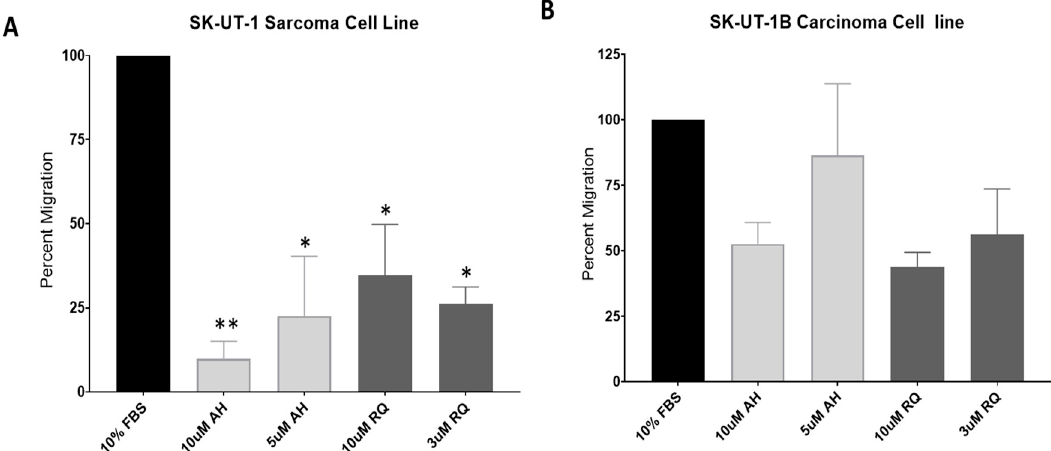
Figure 5. Effect of EP4 antagonists AH23848 and RQ15986 on SK-UT-1 and SK-UT-1B migration. ( A , B ) Addition of EP4 antagonists AH23848 and RQ15986 lead to a decrease in migration in SK-UT-1 and SK-UT-1B. Data are normalized to the FBS control (100%) and presented in percent migration. AH: AH23848. RQ: RQ15986. Statistics: two-way ANOVA with Dunnett’s test. * p < 0.01, ** p <